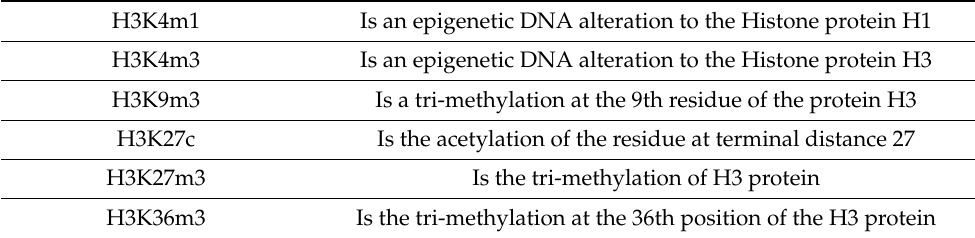
Table 1. Marks that characterize the investigated cancer